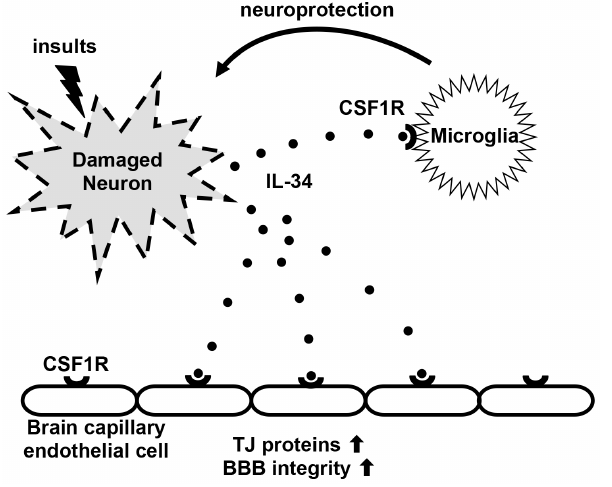
Fig. 5. Model of the roles of IL-34 in the CNS. Damaged neurons secrete IL-34 as a ‘‘Help-me’’ signal. IL-34 binds its receptor CSF1R which is mainly expressed in microglia and BBB endothelial cells. CSF1R signaling enhances neuroprotection in microglia and restores BBB disruption by upregulating TJ proteins in capillary endothelial